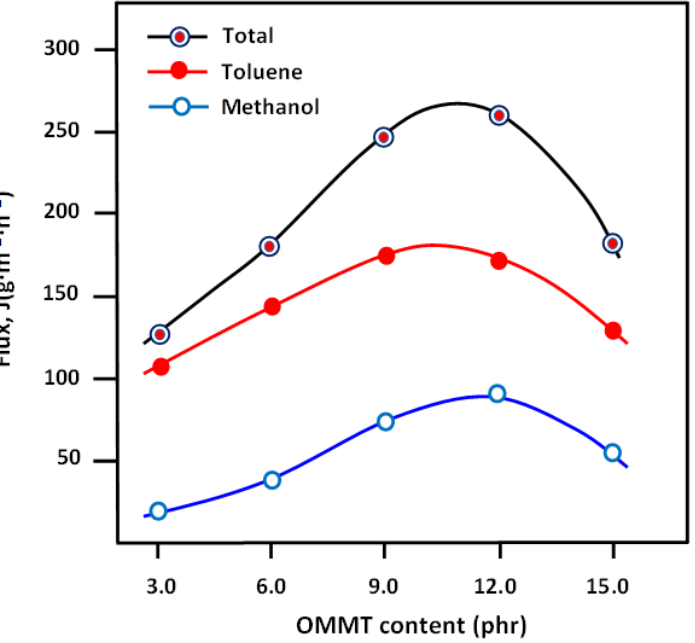
Figure 13. Variation in partial and total fluxes versus the OMMT content in the membrane for the separation of azeotropic toluene−methanol mixture .